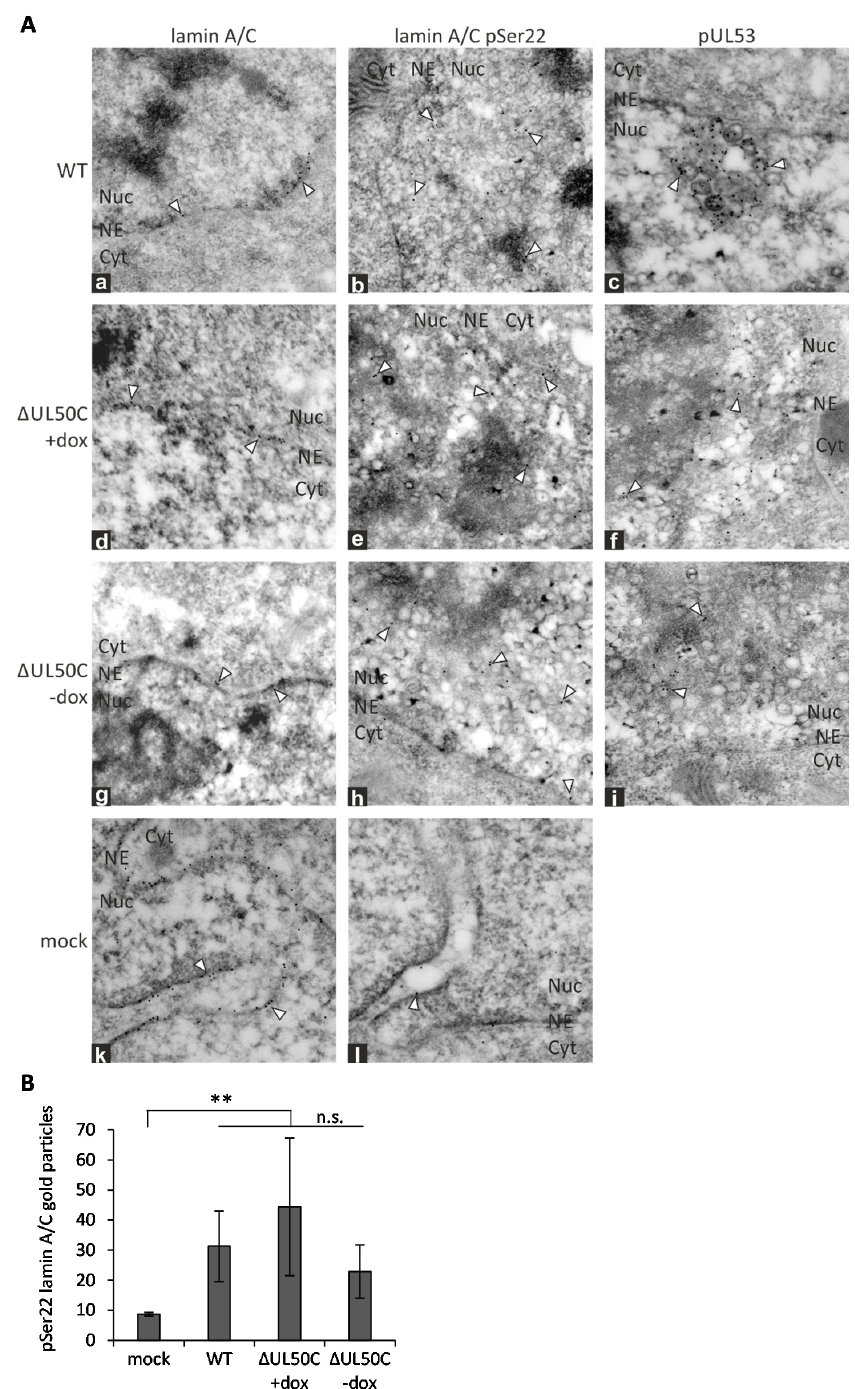
Figure 3. Immunogold EM analysis of WT- and ∆ UL50C virus-infected cells. ( A ) HFF-UL50 +dox or − dox infected with WT ( a – c ) or ∆ UL50C ( d - i ) or remained mock-infected ( k - l ) (identical amounts of viral genomes contained in the inocula). At 6 d p.i., cells were fixed, and were subjected to sectioning and immunogold staining before analysis by EM. Representative nuclei of cells stained against lamin A/C, pSer22 phosphorylation-specific lamin A/C or pUL53, respectively. Individual gold particles were exemplarily marked by arrowheads. NE, nuclear envelope; Cyt, cytoplasm; Nuc, nucleus. ( B ) Quantitation of the pSer22-specific lamin A/C signals by counting the gold particles in duplicates each in at least two nuclear sections. Mean values ± SD are given, significance was calculated by the Student’s t -test (**, p ≤ 0.01; n.s., no significant difference between the three indicated settings of